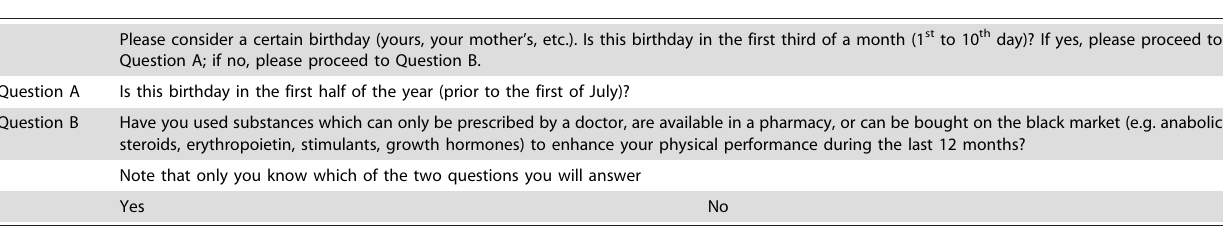
Table 2. RRT procedure to assess physical